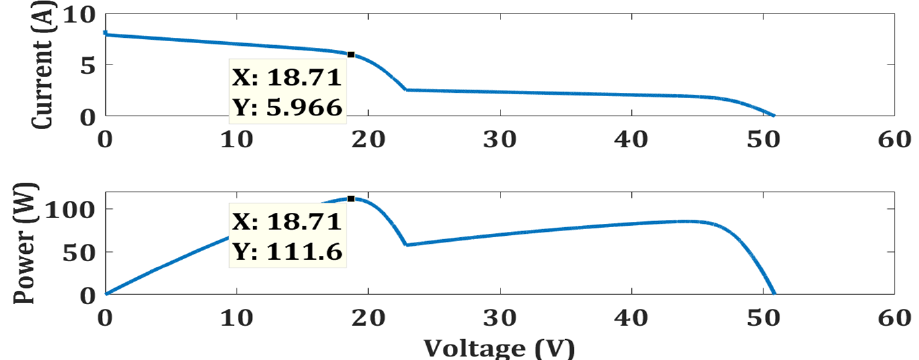
Figure 14. Characteristic curves of 4S2P PV system for test case 2.